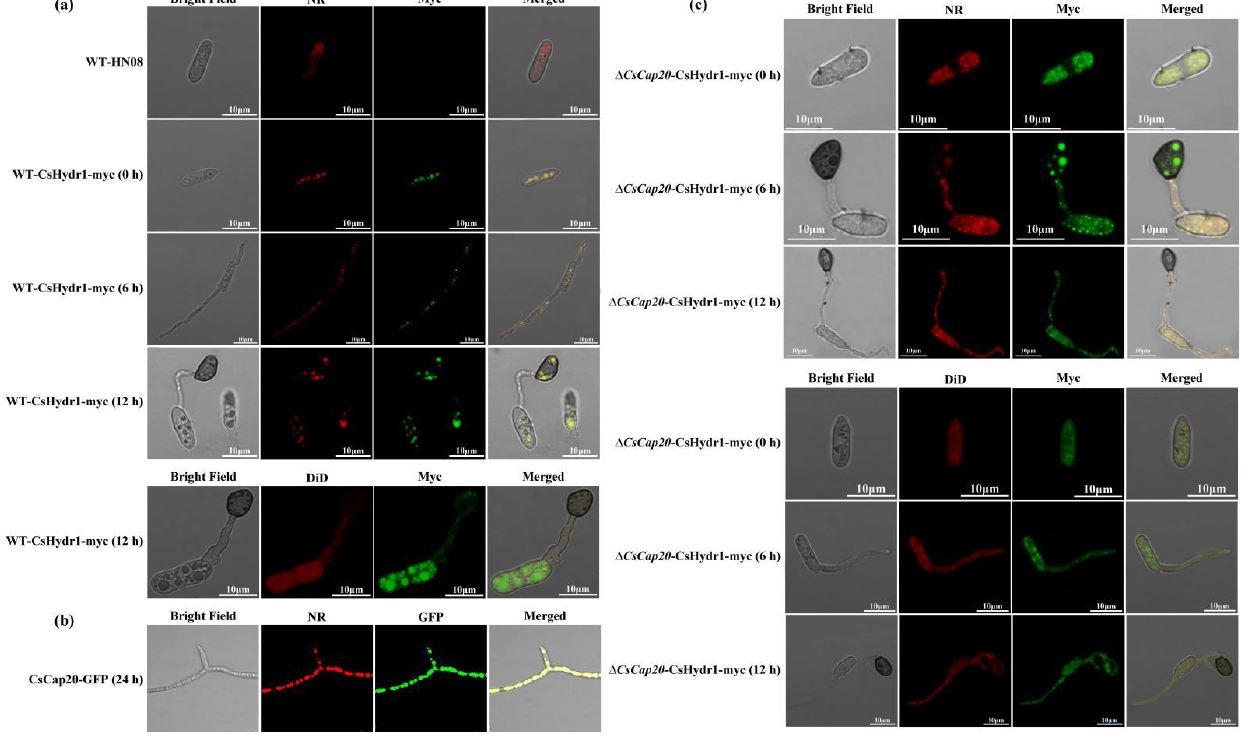
Figure 7. Subcellular localization of the CsHydr1 protein in WT and Δ csCap20 . ( a ) Protein CsHydr1 localization in WT. ( b ) Protein CsCap20 localization in WT HN08. ( c ) Protein CsHydr1 localization